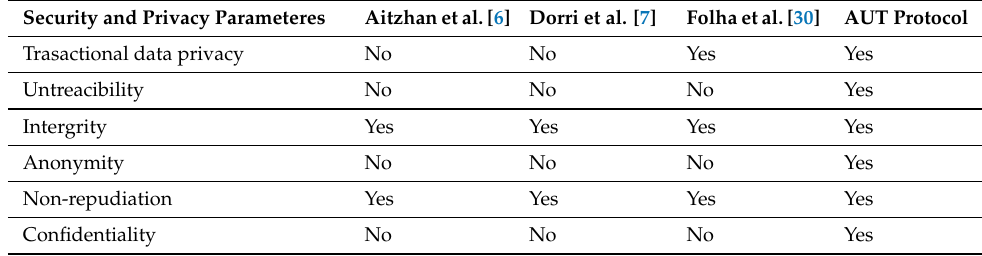
Table 4. Security and privacy